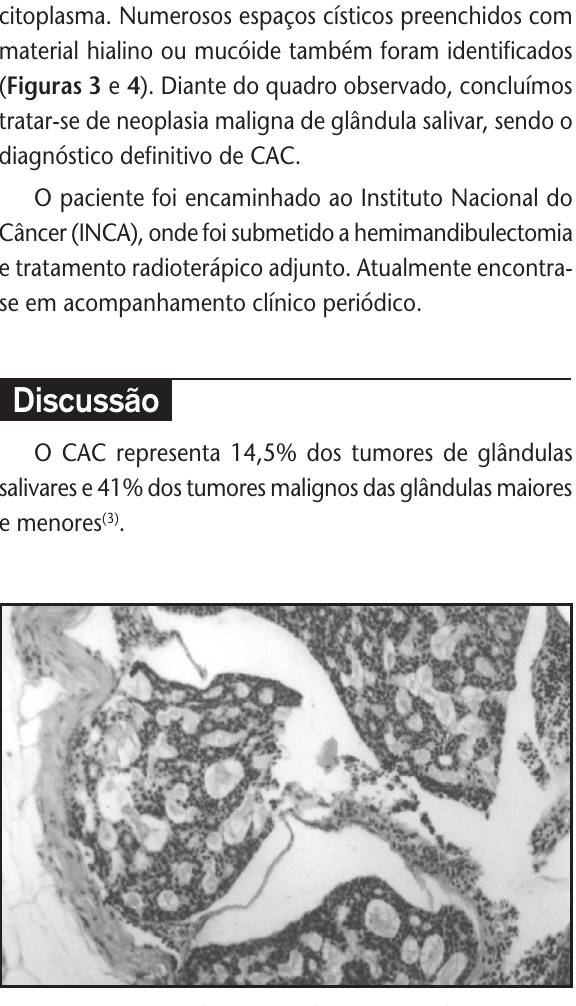
Figura 3 – Aspectos microscópicos: ilhas de células tumorais cubóides pequenas, com núcleo basofílico e pouco citoplasma, caracterizando uma neoplasia maligna originária do epitélio da glândula salivar (HE,